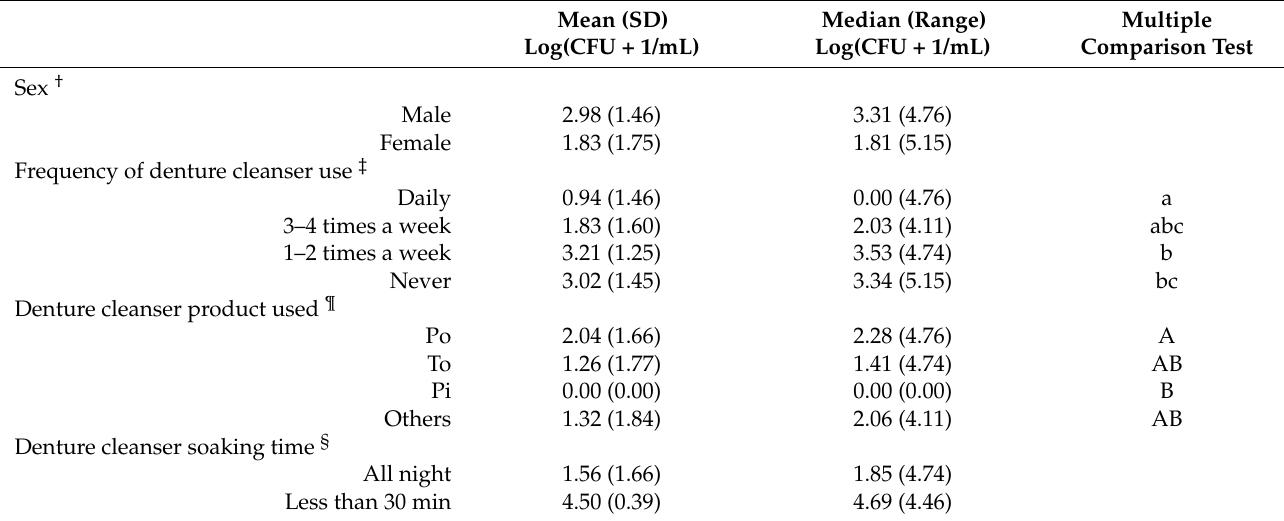
Table 4. Comparison of subgroups of surveyed items that correlated with the number of Candida spp. No significant differences were observed in the number of Candida spp. between subgroups marked with the same letter (Dunn’s multiple comparison test).